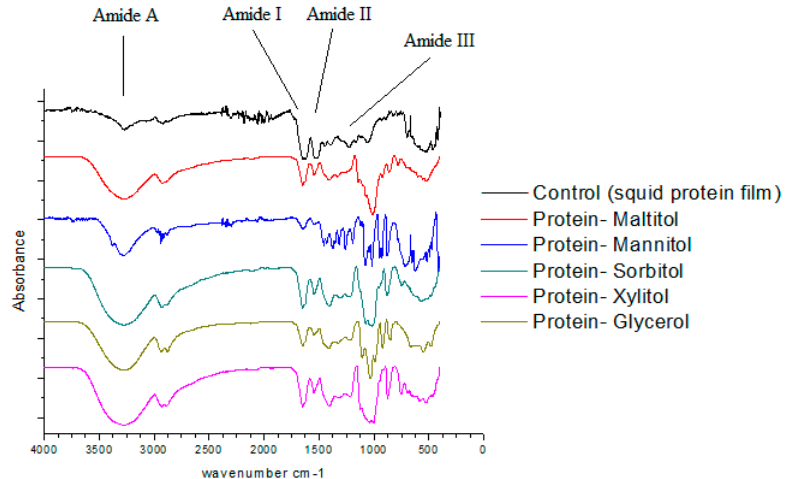
Figure 3. FT-IR spectra of the protein films of jumbo squid ( Dosidicus gigas ), control (only protein) and with the addition of different plasticizers.